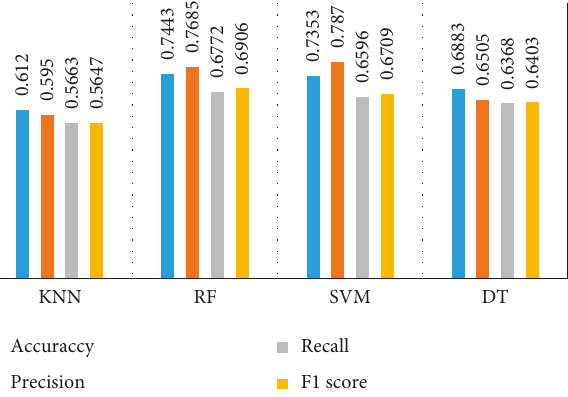
Figure 3: Results after evaluation with all the classifiers used in the study.